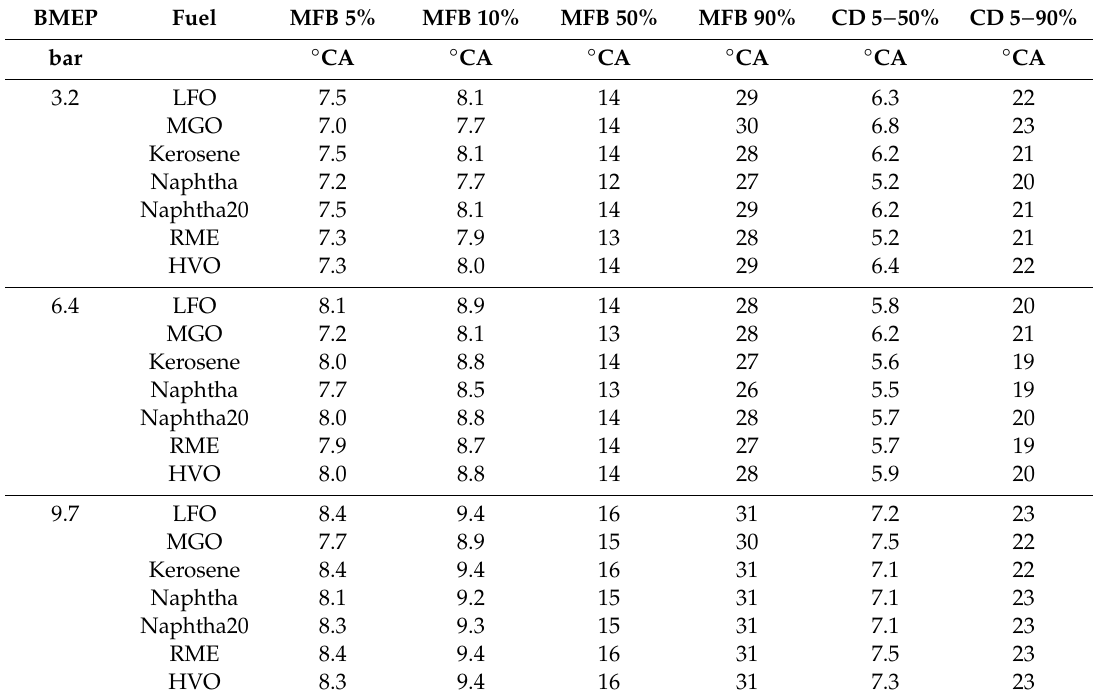
Table 4. Mass fraction burned and combustion durations (MFB 5 − 50% and MFB 5 − 90%).